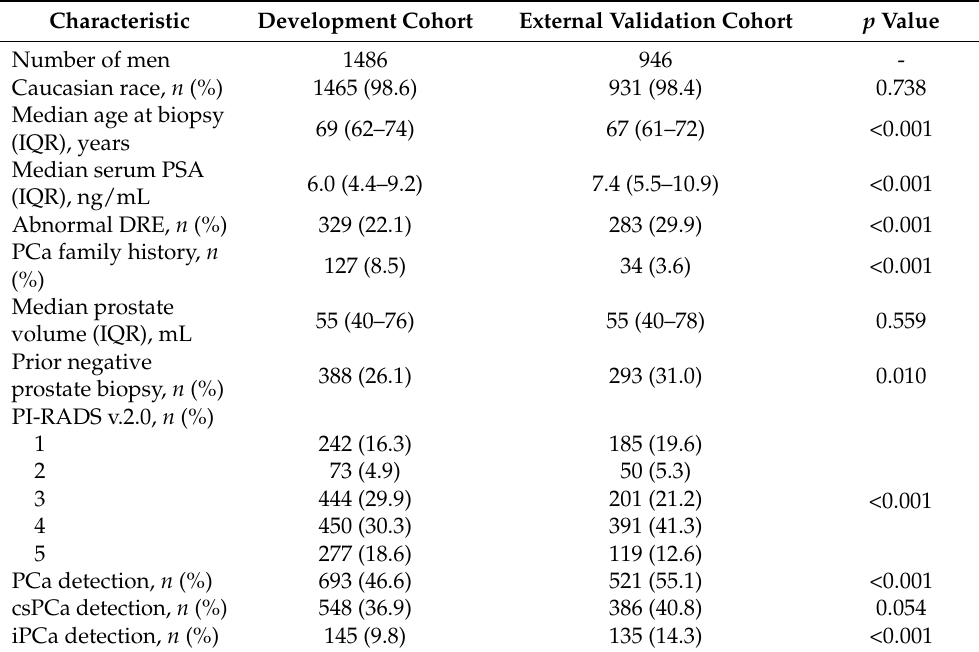
Table 1. Characteristics of men suspected to have PCa in development and external validation cohorts and comparisons between them.